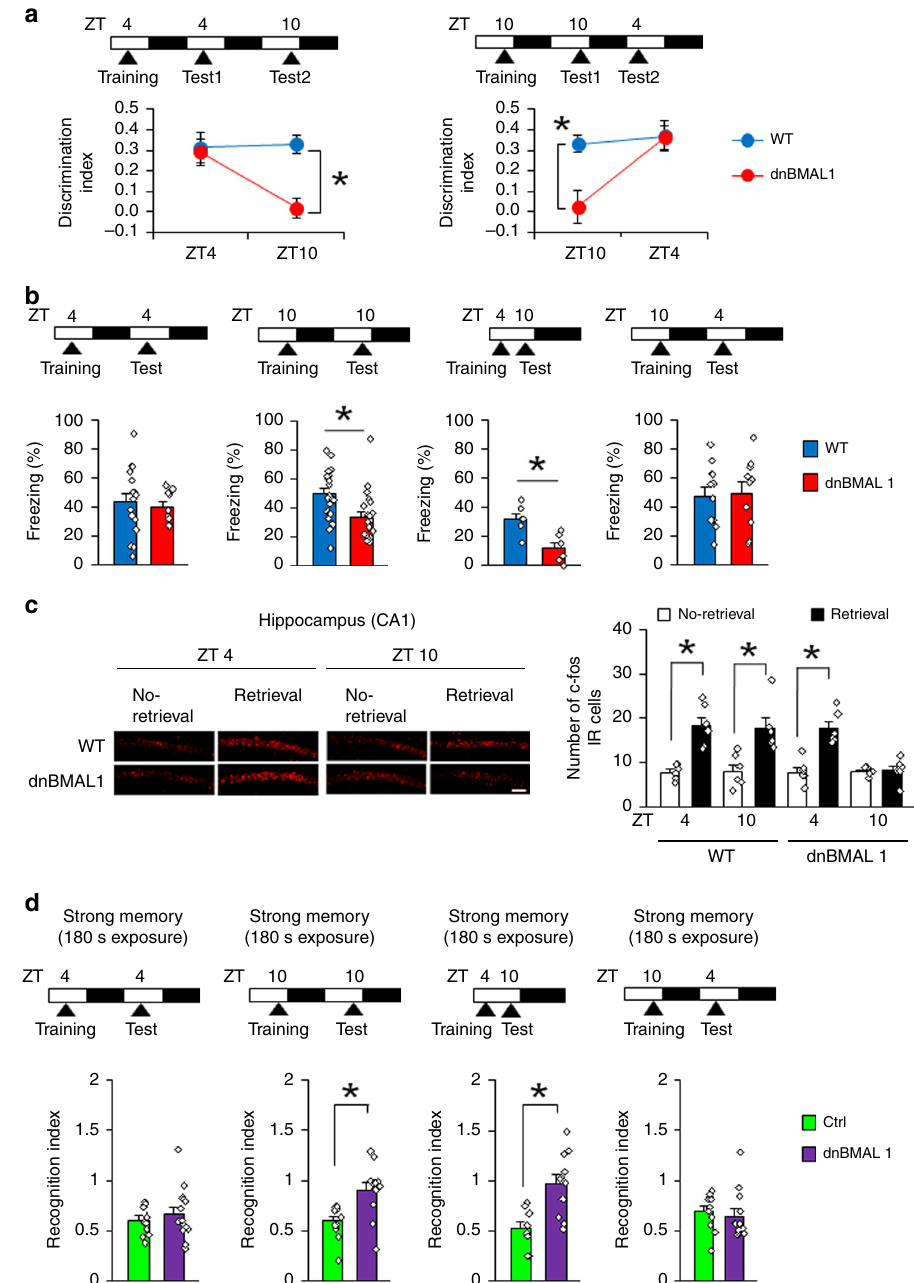
Fig. 4 Memory retrieval de fi cits in dnBMAL1 mice generalize to hippocampus-dependent memory. a , b Experimental designs are illustrated at the top of each panel. Memory retrieval is impaired at ZT10 in dnBMAL1 mice for a novel object recognition task and b contextual fear memory. c Consistent with impaired memory retrieval at ZT10, dnBMAL1 mice show reduced c-fos expression in CA1 region of hippocampus after retrieval of contextual fear memory. (Left panels) Representative images of c-fos immunohistochemistry. Scale bar, 100 μ m. (Right panel) Quanti fi cation of the number of c-fos immunoreactive (IR) cells. d dnBMAL1 expression in the hippocampus impairs retrieval of social recognition memory at ZT10 but not at ZT4 (Recognition index). Experimental designs are illustrated at the top of each panel. One-way ANOVAs with group reveal signi fi cant effect of dnBMAL1 when dnBMAL1 group is tested at ZT10 but not at ZT4. Ctrl control. All values are mean ± SEM. Individual data points are displayed as dots. * p < 0.05 as determined by three-way ( c ), two-way ( a ), or one-way ( b , d ) ANOVA with post hoc test. The results of the statistical analyses are presented in Supplementary Table 2. Source data are provided as a source data fi